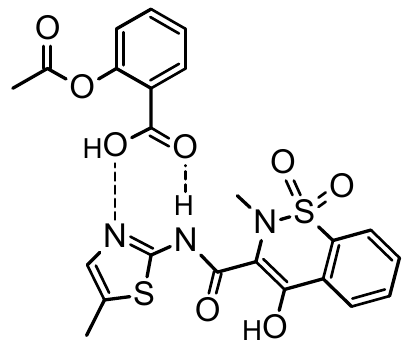
Figure 4. Supramolecular synthon present in 1:1 cocrystal of meloxicam and aspirin.